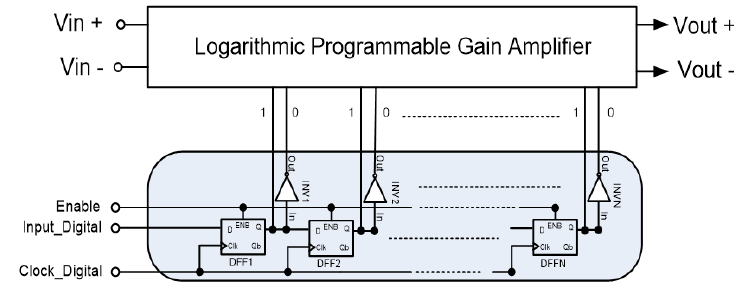
Figure 6. Programming logic diagram of the